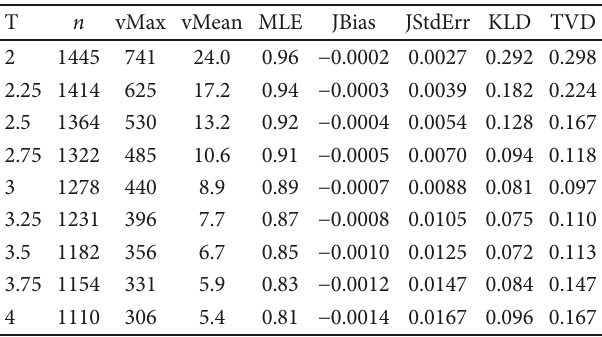
Table 2: Results with P = 1 (zeros